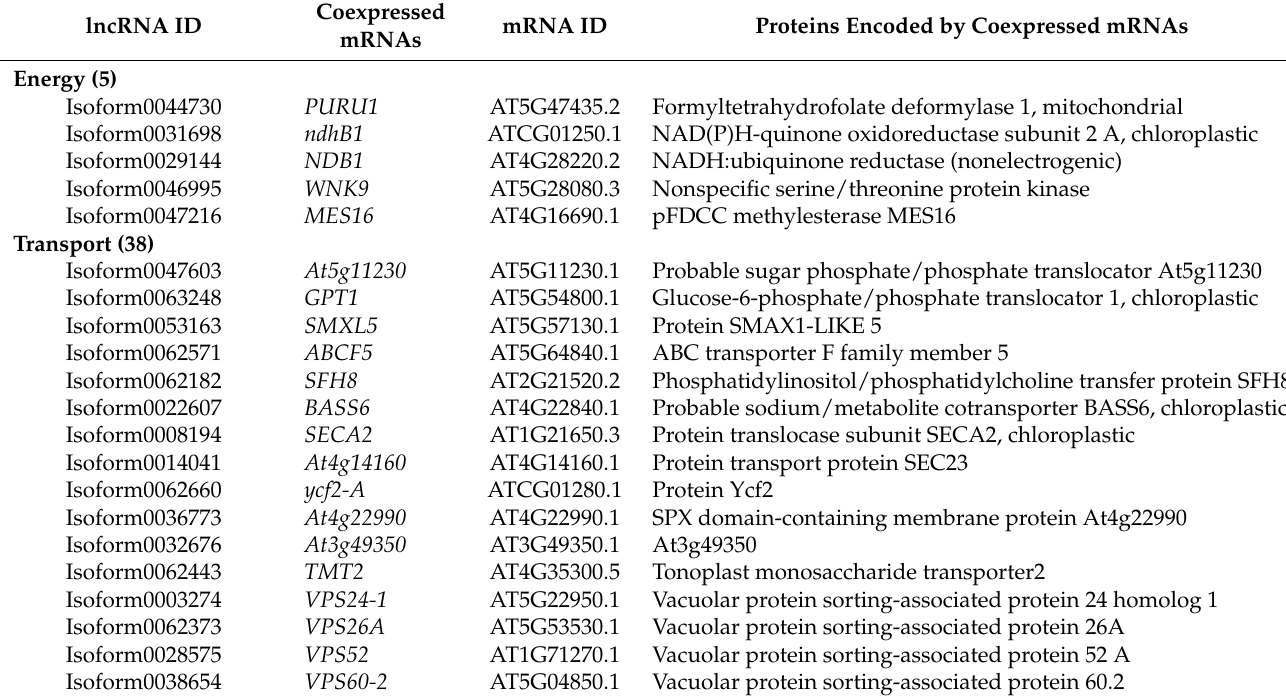
Table 7. Forty-three lncRNAs linked with energy and transport.